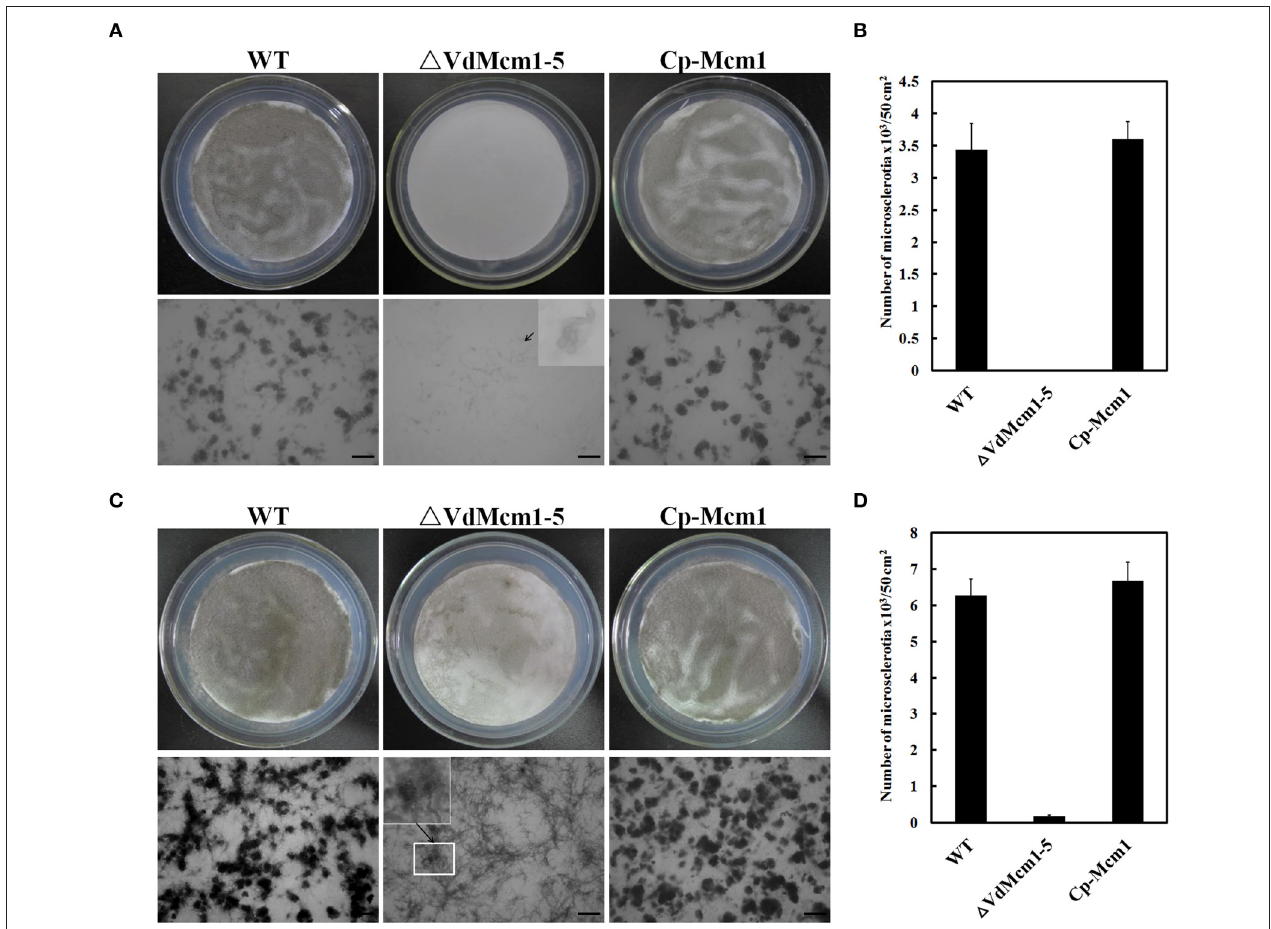
FIGURE 5 | Loss of VdMcm1 causes defects in microsclerotia formation. (A) Microsclerotia formation on BM plates with 10 5 conidia spreading over the cellulose membrane after 6 days of growth. The enlarged view shows the unmelanized and swollen hyphae of 1 VdMcm1-5 . The scale bars represent 100 µ m. (B) The histogram represents the number of microsclerotia formed by the wild-type strain, 1 VdMcm1-5 , and complemented strain on the cellulose membrane ( ϕ = 80 mm) after 6 days of growth. (C) Microsclerotia formation on BM plates after 8 days of incubation. The enlarged view showed the microsclerotia of 1 VdMcm1-5 . The scale bars represent 100 µ m. (D) The histogram represented the number of microsclerotia formed by wild-type strain, 1 VdMcm1-5 , and complemented strain on the cellulose membrane ( ϕ = 80 mm) after 8 days of incubation. The error bars represent standard deviations. The experiments were performed in triplicate.